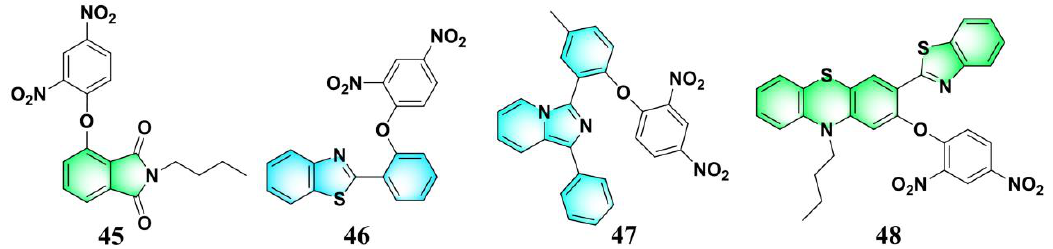
Figure 20. Fluorescent PhSH probes ( 45 – 48 ) based on excited-state intramolecular proton transfer (ESIPT) fluorophores.